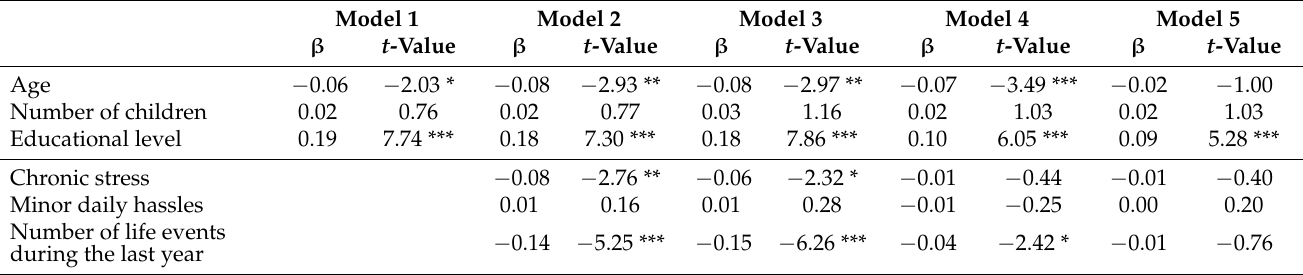
Table 5. Summary of the hierarchical regression with eudaimonic well-being as the dependent variable for